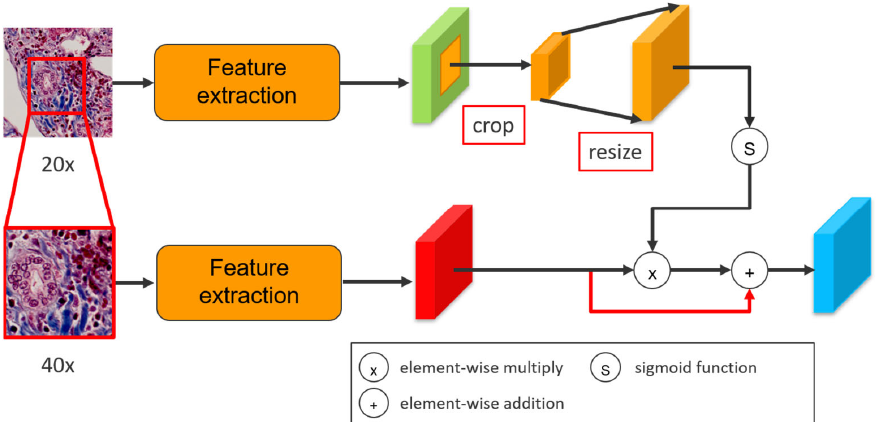
Figure 5. An attention method to enhance the high ‐ magnification feature map.